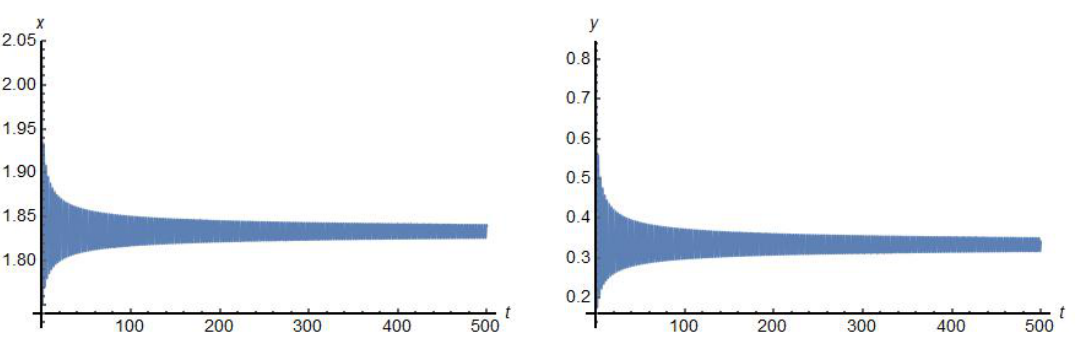
Figure 3. The solution of system (1) with initial conditions x = 2.03 and y = 0.53 and parameter values a = 0.5, b = 0.01, c = 2.04 and K =